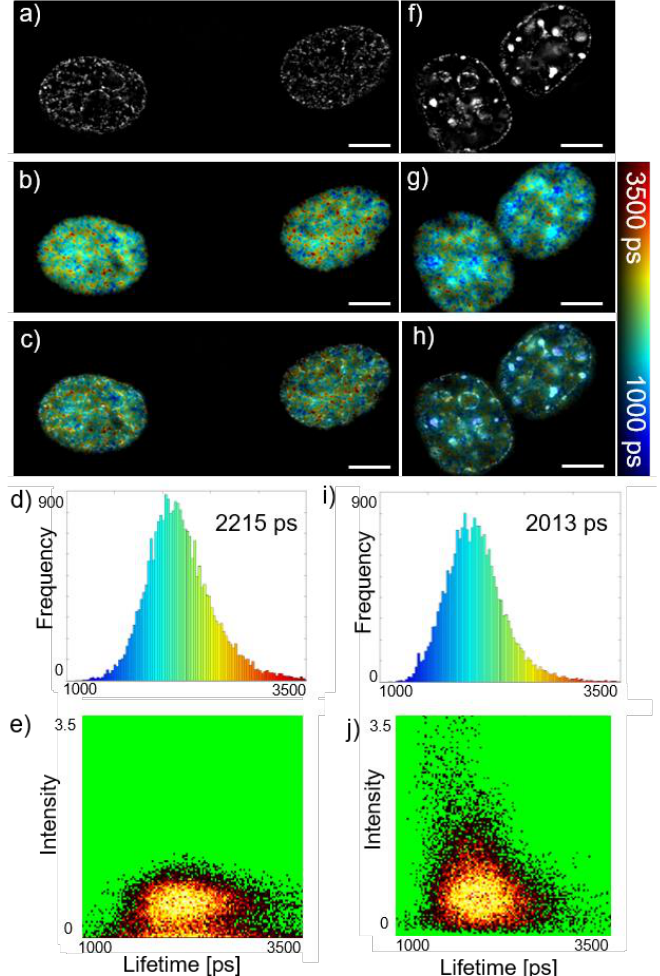
Figure 3. SIM and intensity-weighted fluorescence lifetime images of NIH3T3 cells incorporating EdU that has been stochastically labelled with Alexa 594 or Alexa 647 using click-chemistry. ( a – e ) and ( f – j ) show cells in S-phase with different degrees of chromatin compaction. ( a , f ) show the Alexa594 SIM images, ( b , g ) show the intensity-weighted Alexa594 fluorescence lifetime images, ( c , h ) show the SIM + FLIM images, ( d , i ) show the corresponding intensity-weighted fluorescence lifetime histograms with intensity-weighted mean lifetime values inset (STD can be found in Table 1), and ( e , j ) show 2D histograms of Alexa594 intensity versus lifetime. (Scale bar: 6 µ